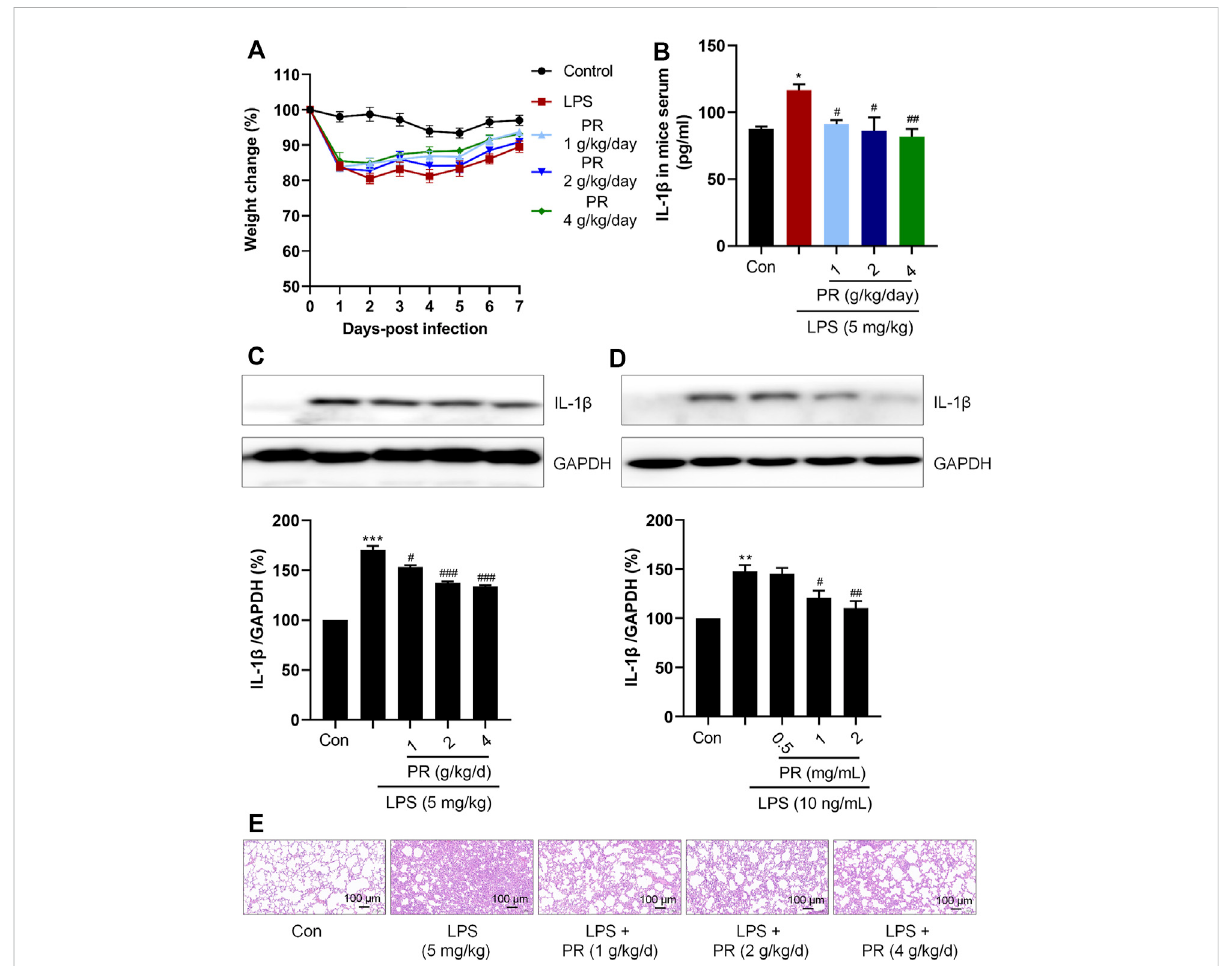
FIGURE 2 PRexhibitsanti-in fl ammatoryef fi cacyinLPSstimulation. (A) bodyweightchangeofmicein7 daysduring administration. (B) SerumIL-1 β levels were detected by Elisa kits ( n = 5 – 6). (C) Immunoblot was employed to evaluate the expression of IL-1 β in lung tissue of mice. (D) RAW264.7 cells were treated with LPS or/and PR for 12 h, followed by Western blot analysis using IL-1 β antibody ( n = 3). (E) Representative HE staining of lung tissue from ALI mice that were treated or untreated with PR ( n = 6). Scale bar = 100 μ m *p < 0.05 , **p < 0.01 , ***p < 0.001 , ****p < 0.0001 vs. Control groups ; #p < 0.05 , ##p < 0.01 , ###p < 0.001 , ####p < 0.0001 vs. LPS-treated